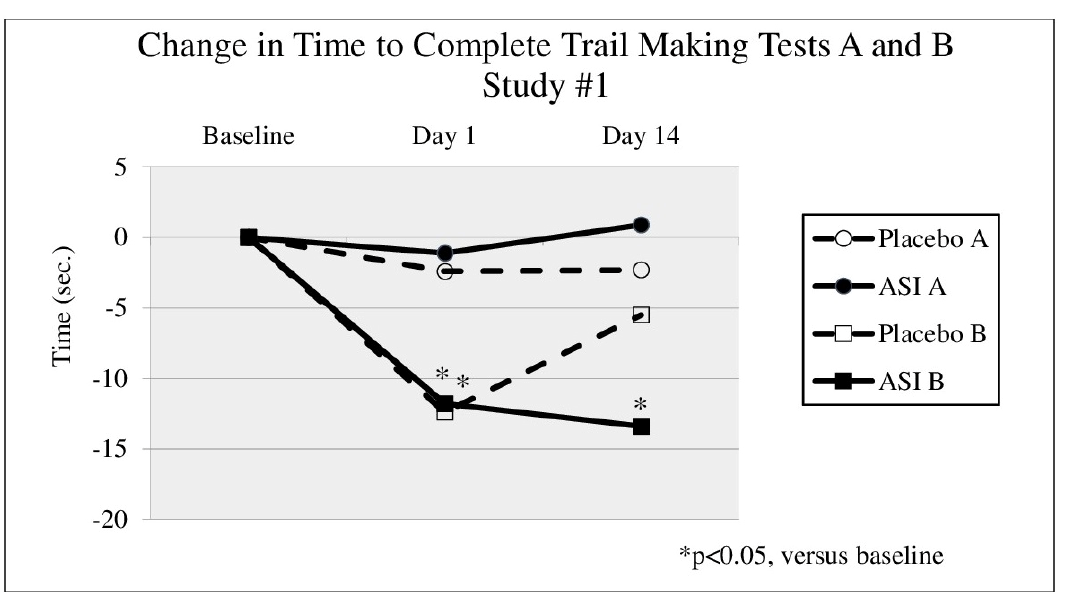
Figure 1. Change in time from baseline to complete Trail Making Tests (TMT) A and B, 10–15 min after a single dose and pre-dose after 14 days of inositol-stabilized arginine silicate (ASI) supplementation.